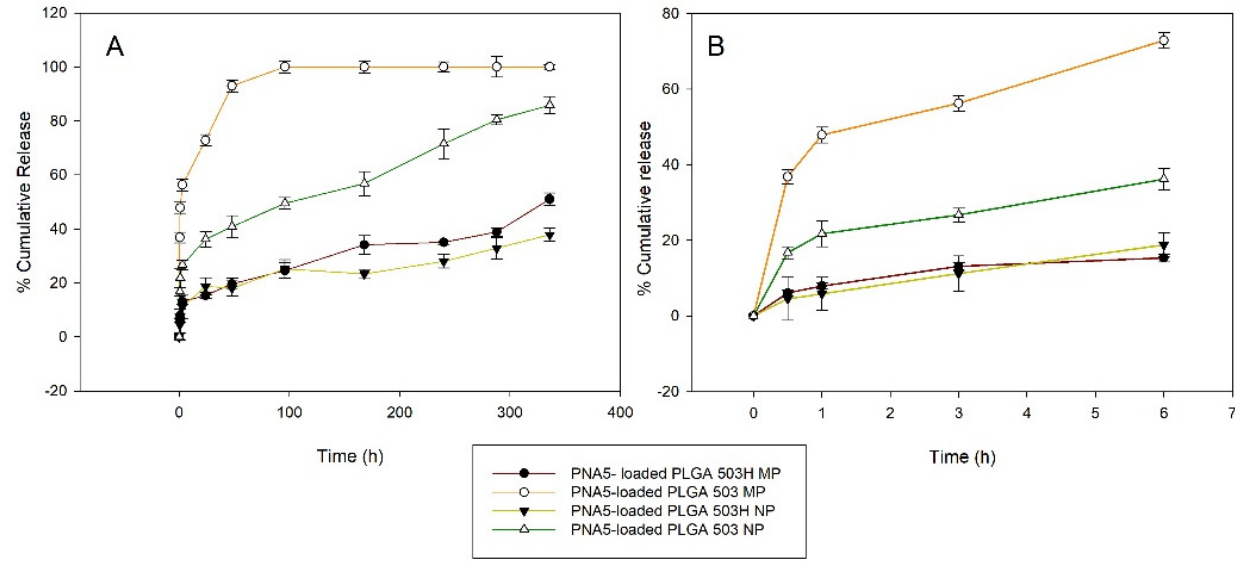
Figure 4. In vitro cumulative release of PNA5 glycopeptide over time from PLGA 503H and PLGA 503 polymeric nanoparticles and microparticles at pH = 7.4 and 37 °C. ( A ): 0–14 d; ( B ):0–6 h.